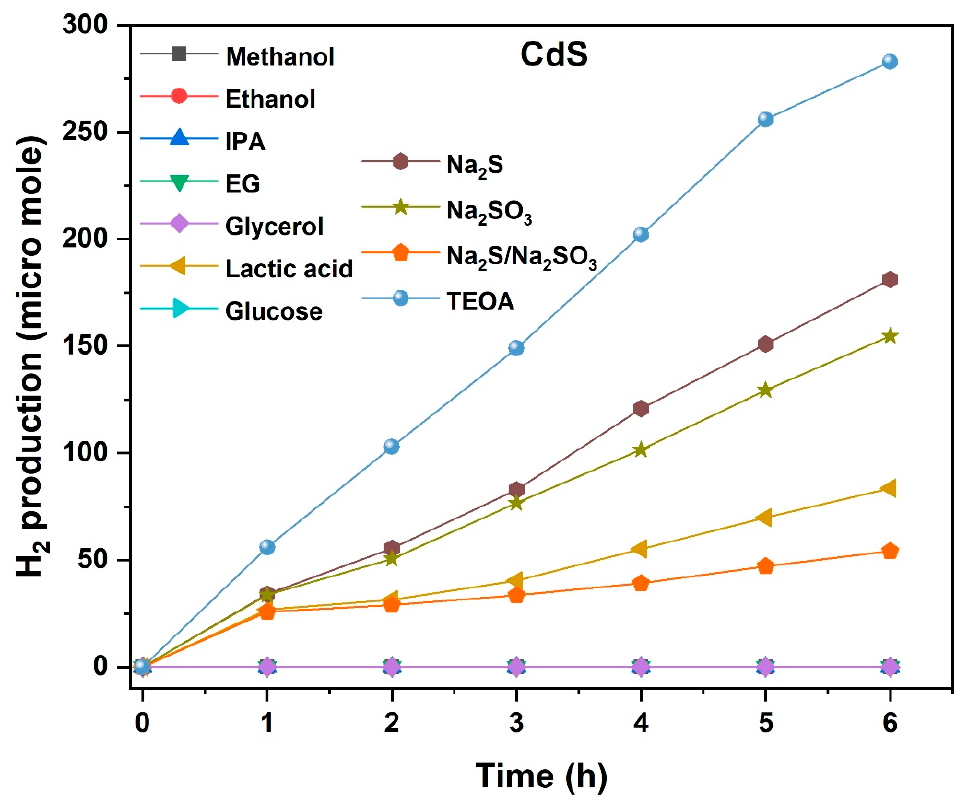
Figure 4. Photocatalytic H 2 production efficiency of CdS using various sacrificial agents.